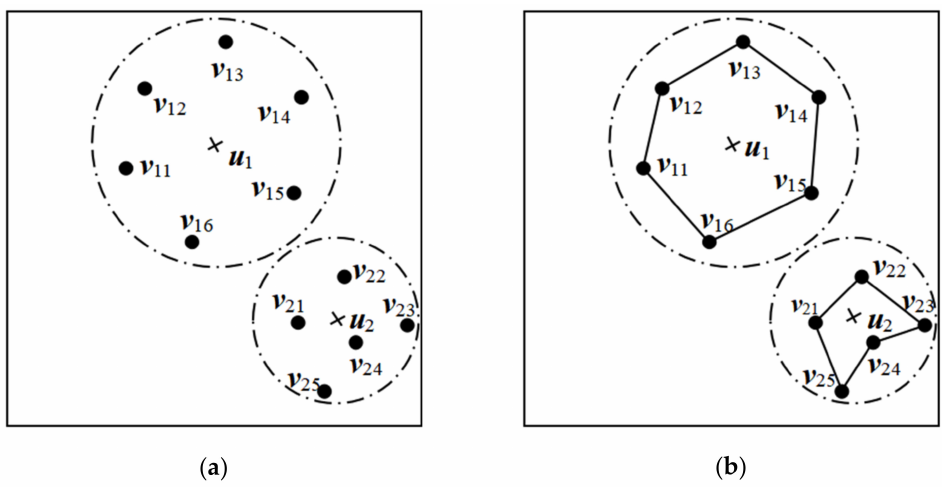
Figure 1. Mark clustering point process to model ground object geometry: ( a ) The clustering point process; ( b ) The mark clustering point